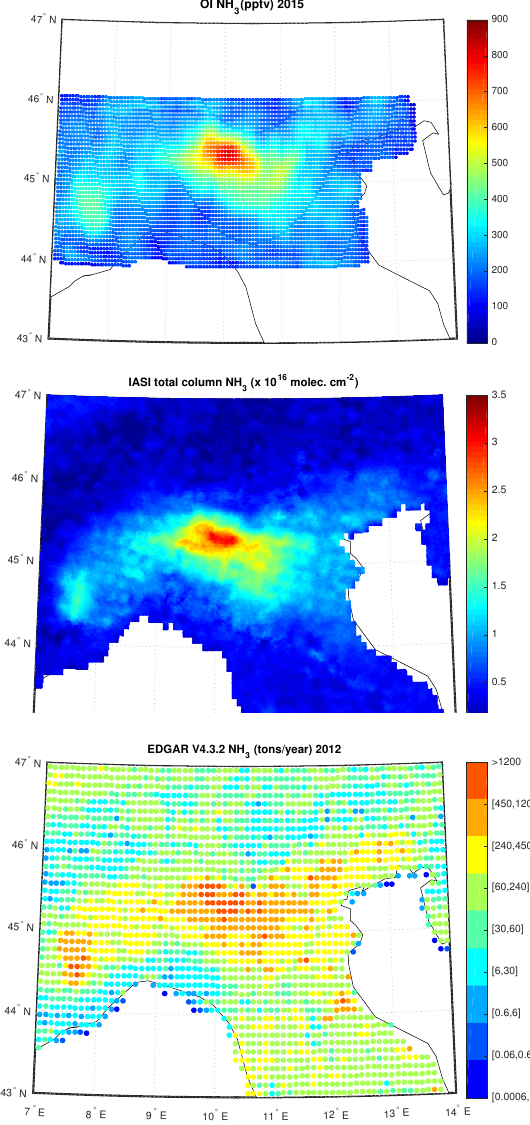
Figure 14. Average OI NH 3 for the year 2015; total column of nine-years global IASI average NH 3 distribution; EDGAR V4.3.2 NH 3 for the year 2012 over